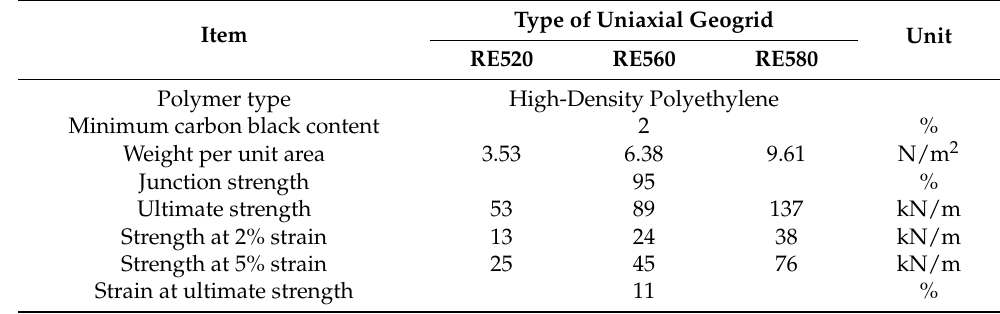
Table 2. Physical and mechanical properties of the uniaxial geogrid used.